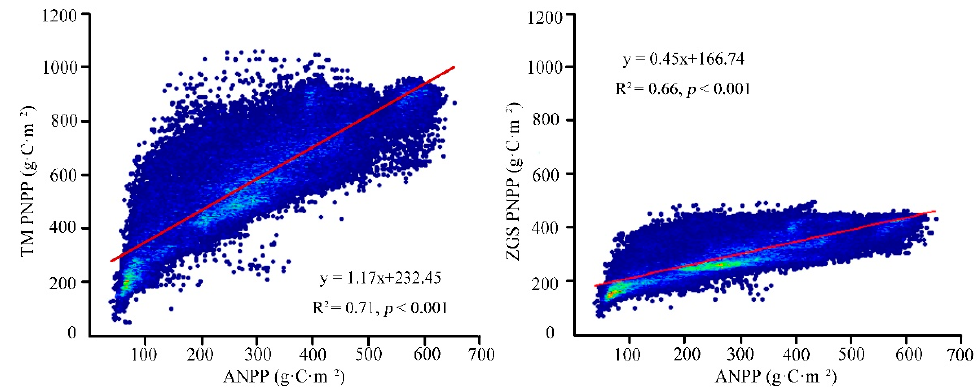
Figure 3. Diagram comparing the PNPP and the ANPP.